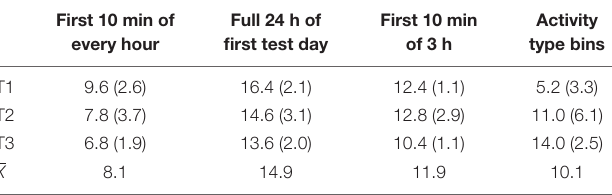
TABLE 1 | Mean number of additional HRV episodes ( SD ) identified in three test days of 24 h